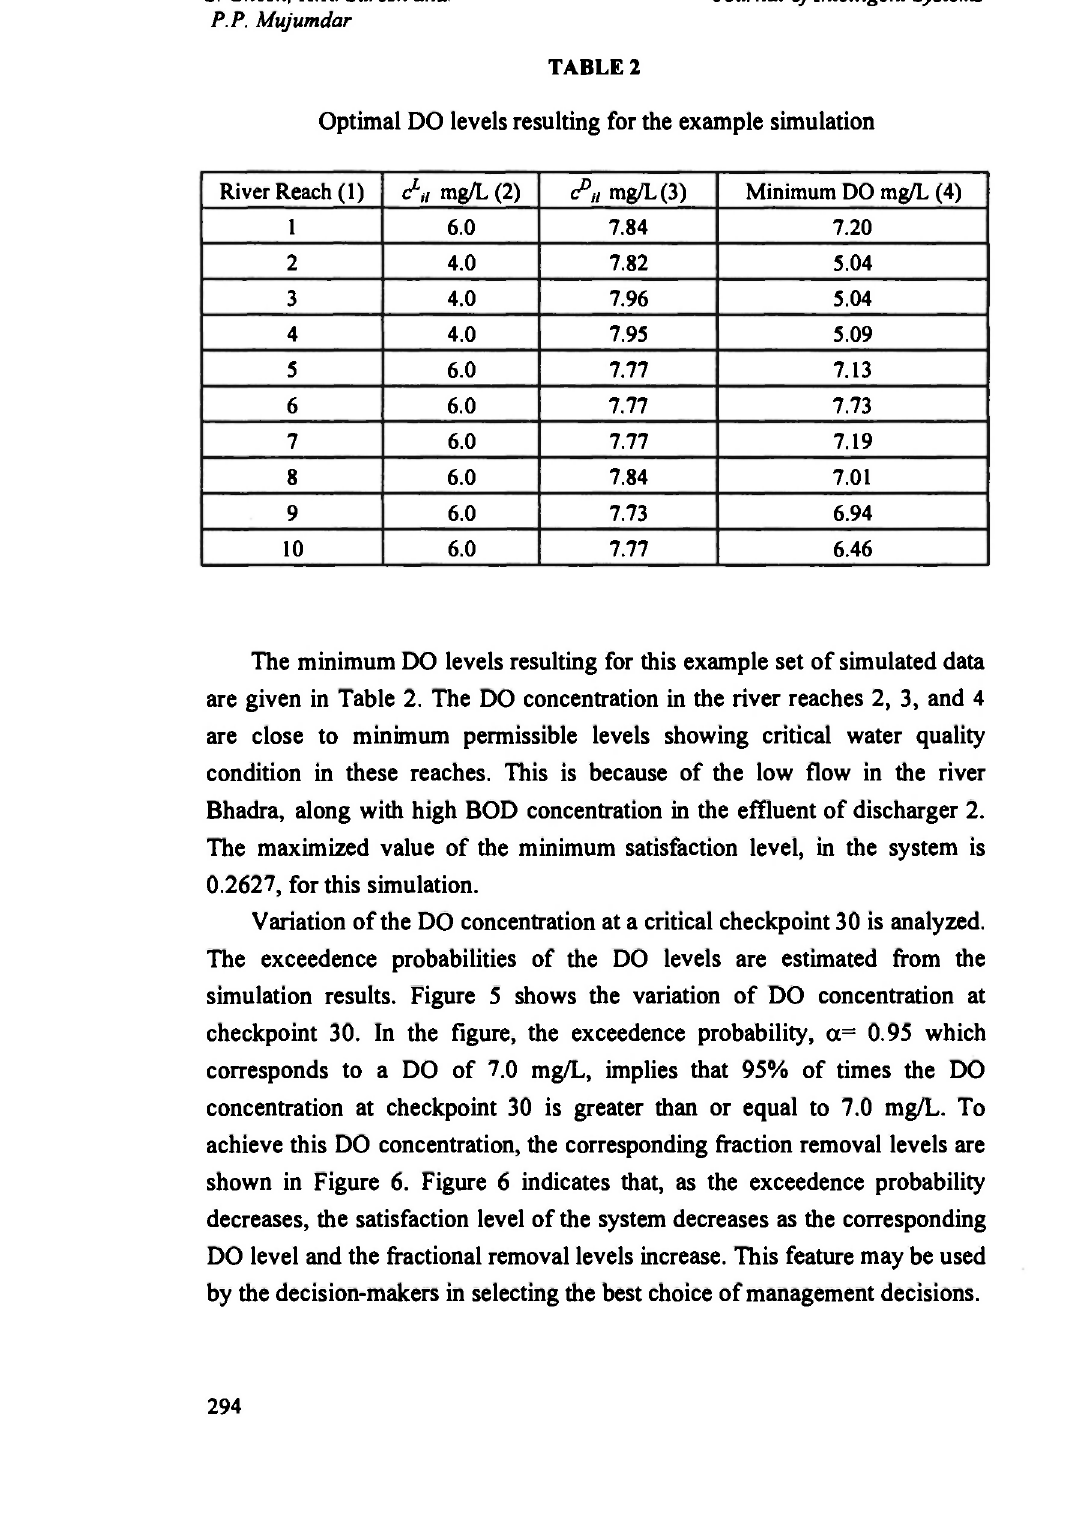
Optimal DO levels resulting for the example simulation River Reach